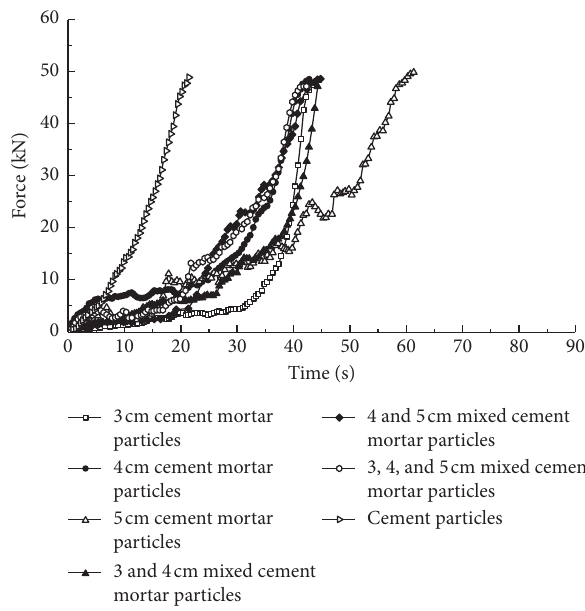
Figure 5: The overall load time-history curves of different particles under the same